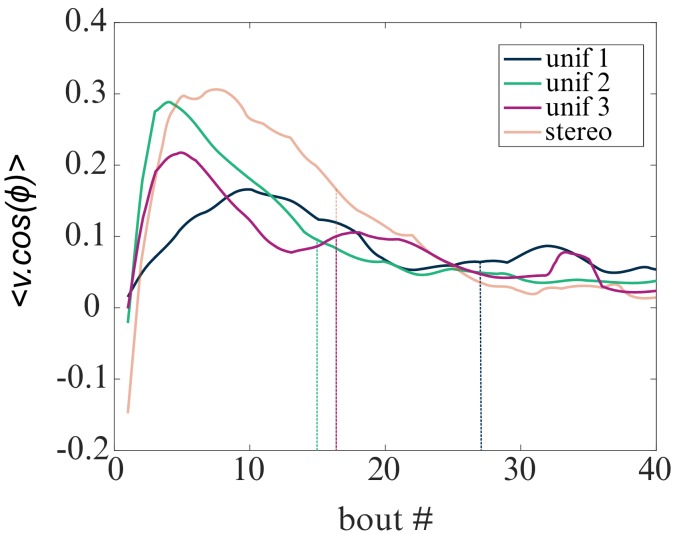
Evolution of the mean resultant vector projected on the direction of the virtual light source with the bout index.Evolution of the mean resultant vector v projected on the direction of the virtual light source with the bout index for the four tested phototactic modalities (uniform illumination : (p1–p3) and stereo-visual contrast). The vertical lines indicate the median number of bouts per sequence in each modality.